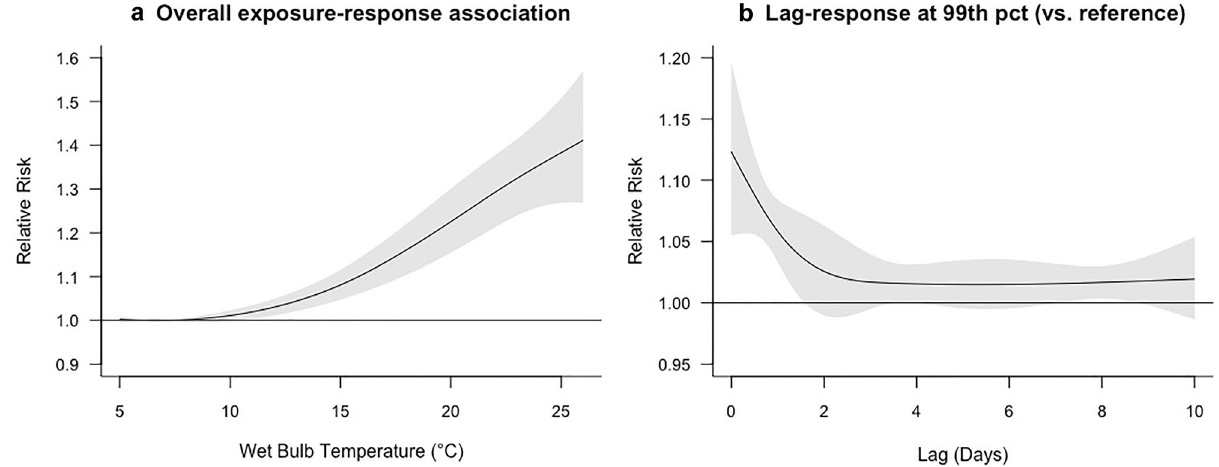
Figure 2. ( a ) The overall cumulative exposure–response relationship between daily WBT cumulated over 10-day lag period and kidney stone presentations, relative to 6.7 °C. ( b ) The lag-response relationship shows the distribution of risk over 10 days following a daily WBT at the 99th percentile, relative to the referent temperature of 6.7